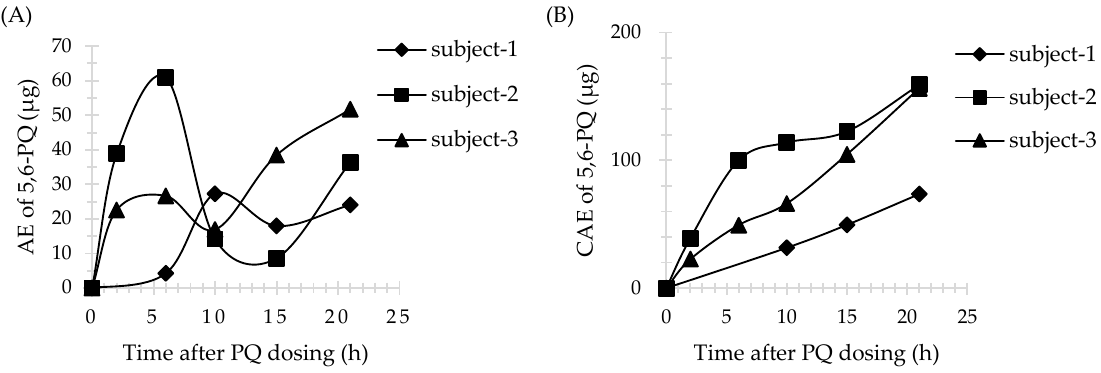
Figure 4. PQ in human urine ( n = 3). ( A ) The amount of drug excreted (AE) versus time profile; ( B ) The cumulative amount of drug excreted (CAE) versus time profile. Time was the midpoint time of the urine collection interval.